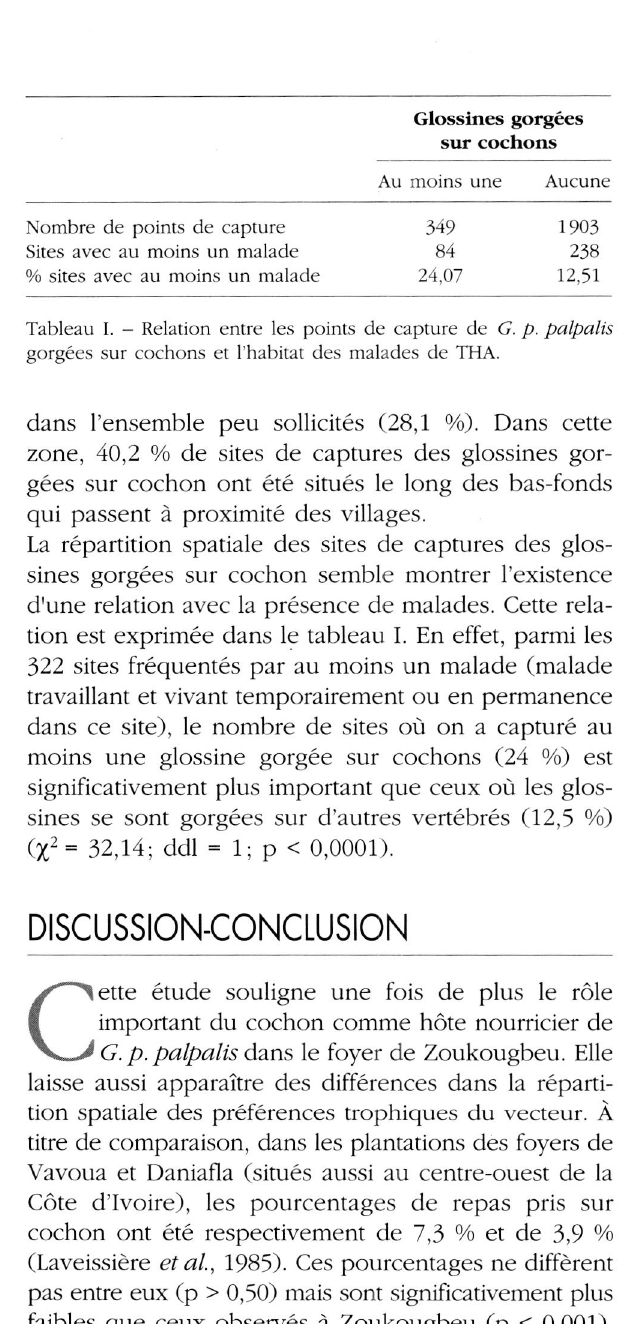
Fig. 1. - Répartition des repas pris par G. p. pal palis dans le foyer de